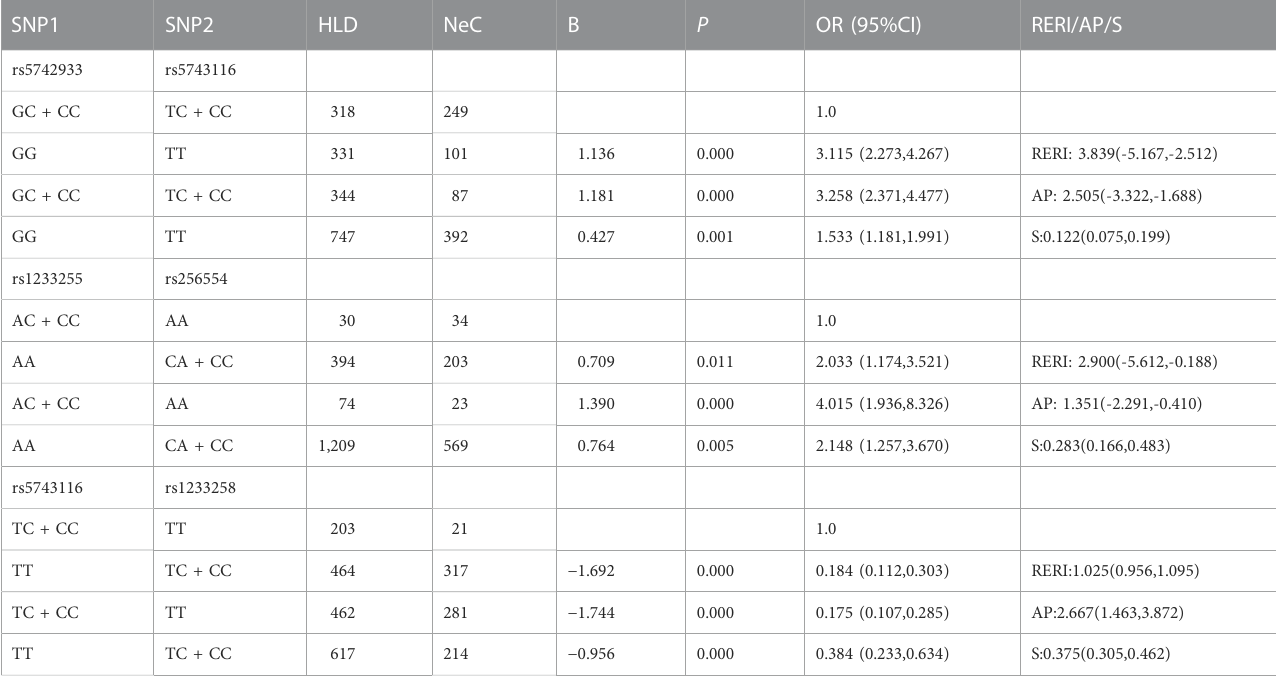
TABLE 5 The positive results of additive interaction analysis of 11 loci and four other factors in NeC vs. HLD group. SNP1